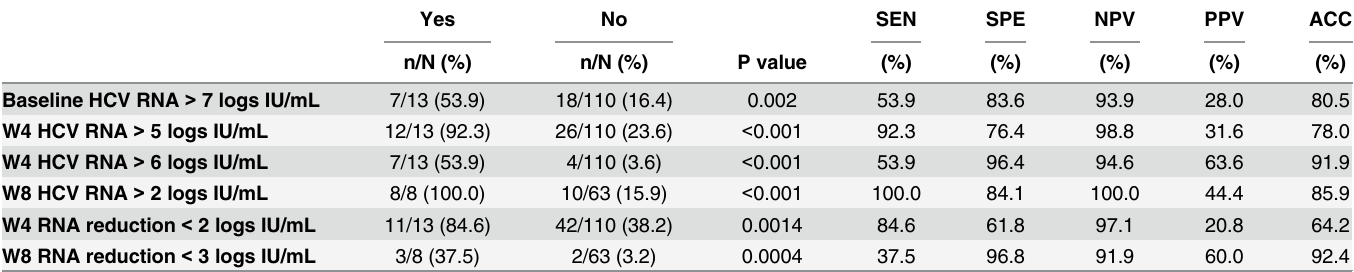
Table 6. Accuracy of viral kinetics in predicting week 12/24 futility. Abbreviations: AUC, area under the curve; SEN, sensitivity; SPE, specificity; PPV, positive predictive value; NPV, negative predictive value; ACC, accuracy.